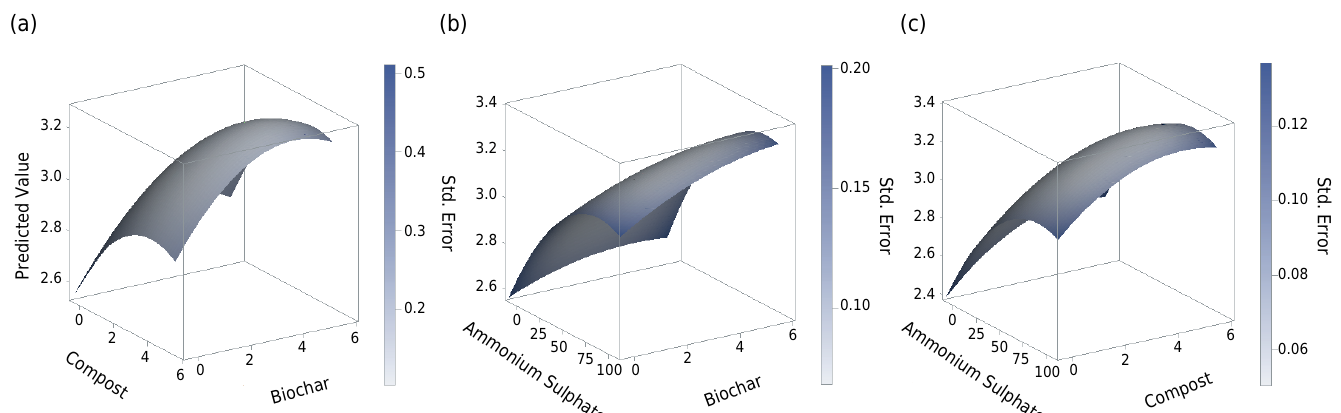
Figure 2. The NRA (mmol kg -1 h -1 NO 2- ) response to independent variable: a) biochar (t ha -1 ) and compost (t ha -1 ); (b) biochar (t ha -1 ) and ammonium sulphate (kg ha -1 ); (c) compost (t ha -1 ) and ammonium sulphate (kg ha -1 ).